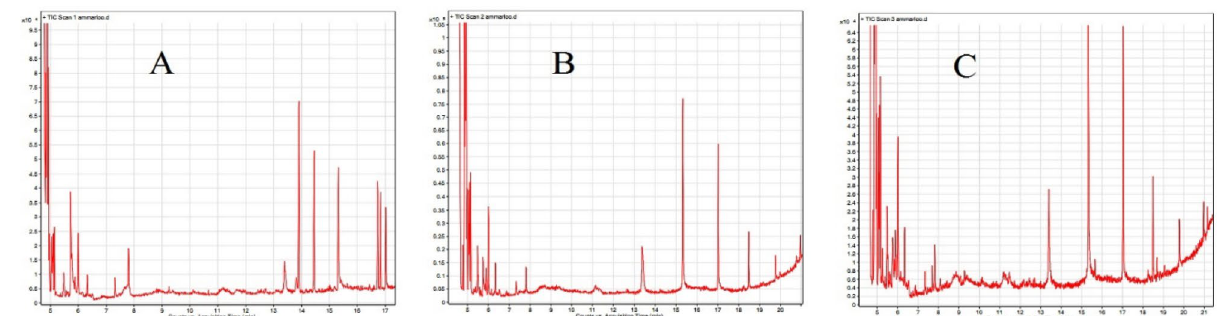
Figure 10. GCMS chromatograms of nettle hair raw extracts with N-hexane + methanol in 3 repeats ( A – C ). Because most of the experimental peaks were observed up to 17 min, no other important peaks were observed after 17–20